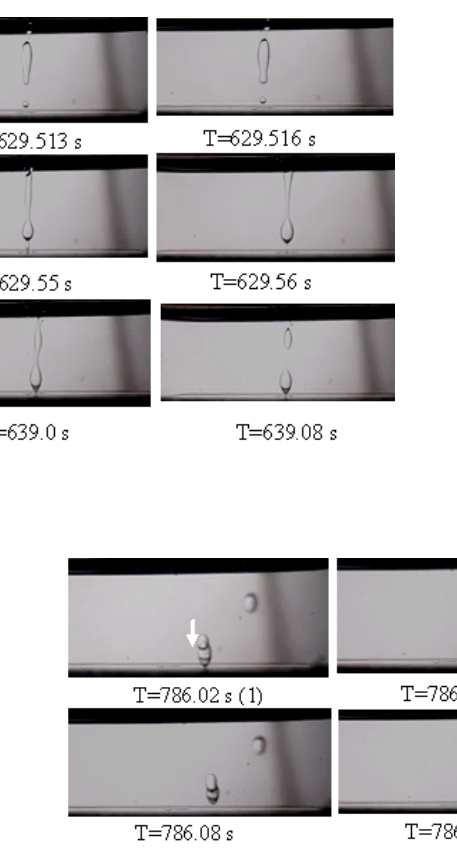
Figure 12. The second type of droplet coalescence (Ca E = 0 . 334). Fig. 12. The second type of droplet coalescence (Ca E =0.334).